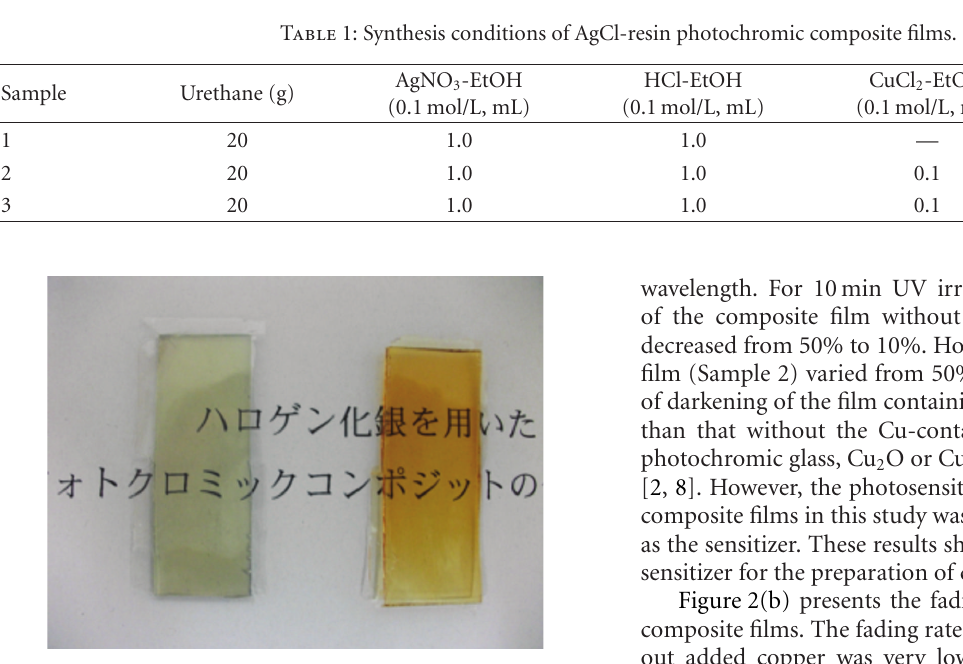
Figure 1: Photographs of composite films (Sample 1 in Table 1) before and after UV